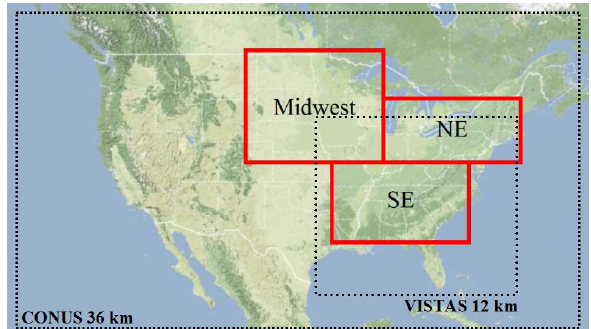
Fig. 1. The CONUS 36 km and VISTAS 12 km domains with selected study areas boxed in red (the dark green color on the map indicates locations of vegetation).